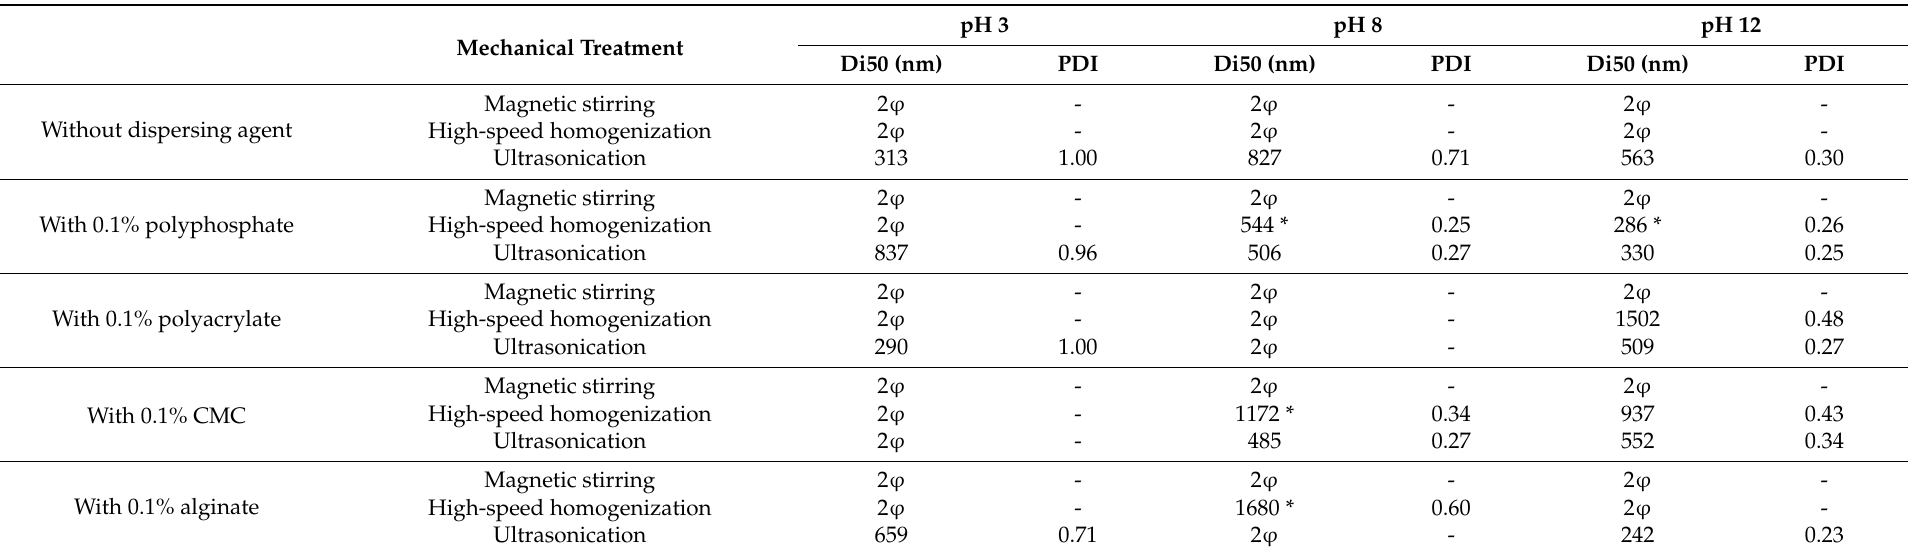
Table 2. Particle sizes of palygorskite as a function of the different conditions used for preparation of the